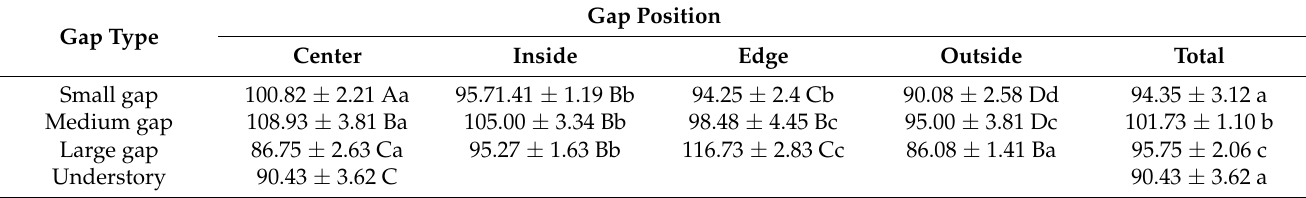
Note: A, B, C, and D indicate differences in the same gap position with different sizes; a, b, c, and d show differences in the different positions within the same gap ( p < 0.05).